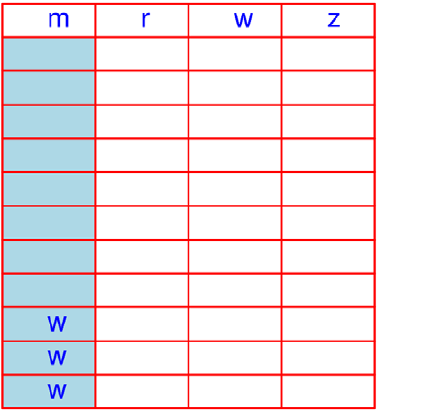
Figure 9. Example of ‘‘whitening’’ strings corresponding to aligned features. The rows with the ‘‘w’’ letter represent the strings of aligned features. Following quicksort these rows will be at the bottom of the S list and will not be re-visited in subsequent